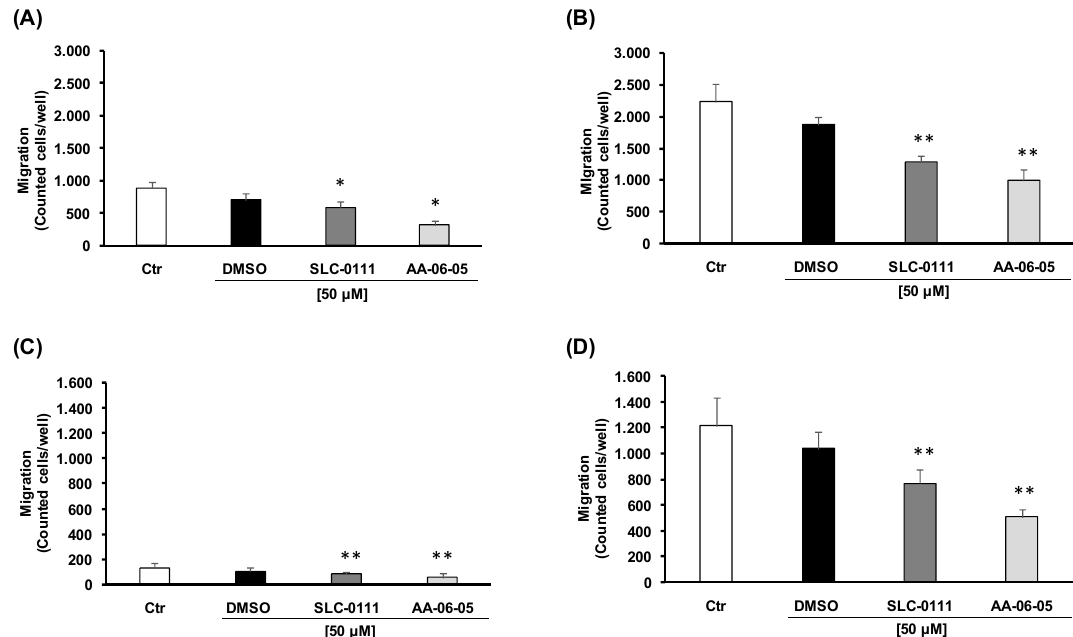
Figure 6. CA-IX inhibition reduces the migration ability of MDA-MB-231 and A549 cells. In suspension tumor cells were treated with a sub-toxic dose [50 µ M] of SLC-0111 and AA-06-05, for 30min. To assess the migration ability of MDA-MB-231( A , B ) and A549 ( C , D ), the Boyden Chamber assay was performed with cells suspended in basal condition of medium with 0.1% FBS, and toward two serum gradients: 1% FBS ( A , C ) and 5% FBS ( B , D ) added in the lower compartments. Data were reported as counted cells for each well ( n = 3). * p < 0.05 and ** p < 0.01 vs. untreated cells (Ctr).